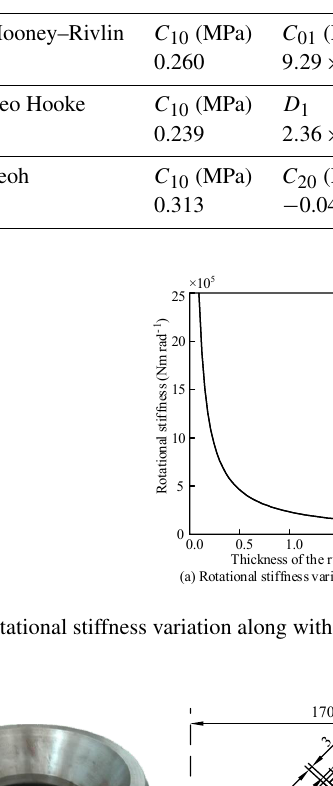
Table 2. Coefficients of constitutive model.